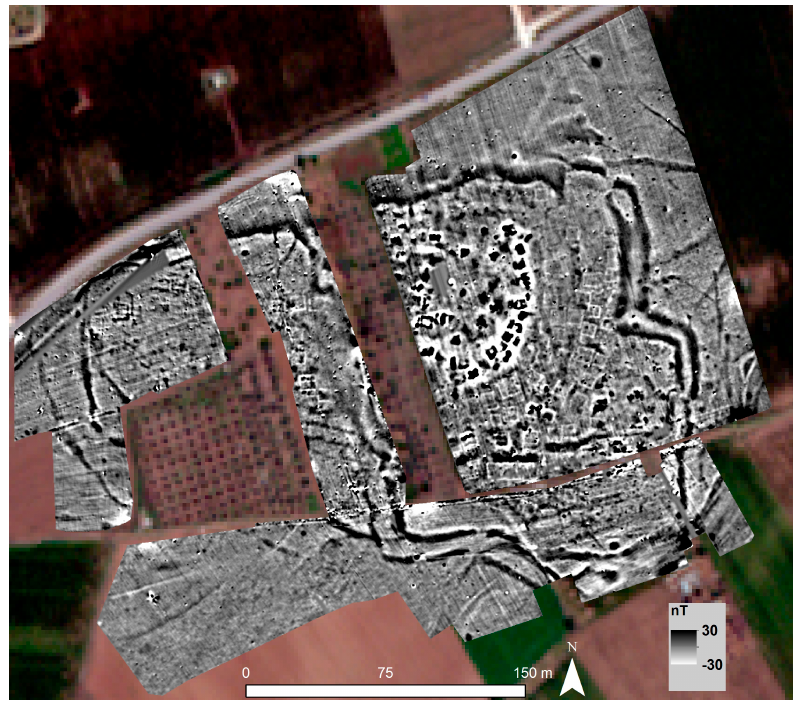
Figure 8. Geomagnetic data from Magoula Almyriotiki. Two distinct architectural groups and settlement enclosures are clearly visible.